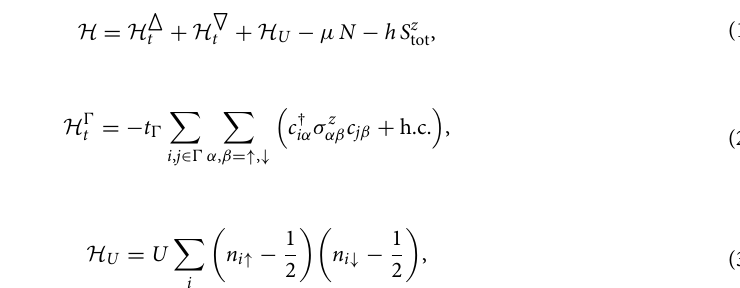
z N UC tot (cid:30) /